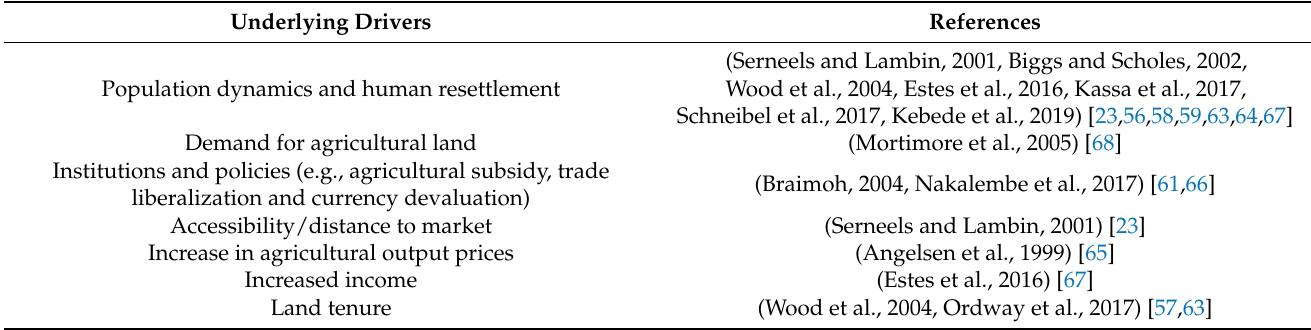
Table 4. Underlying drivers of agricultural